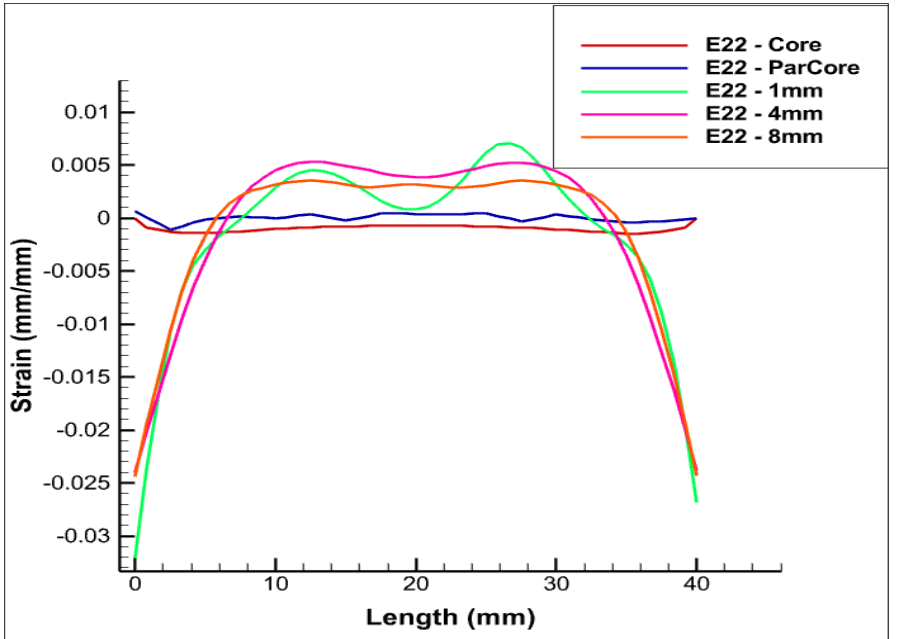
Figure 7. E yy Eyy for various positionings of FOS in the case of the pure bending test case, along y axis.